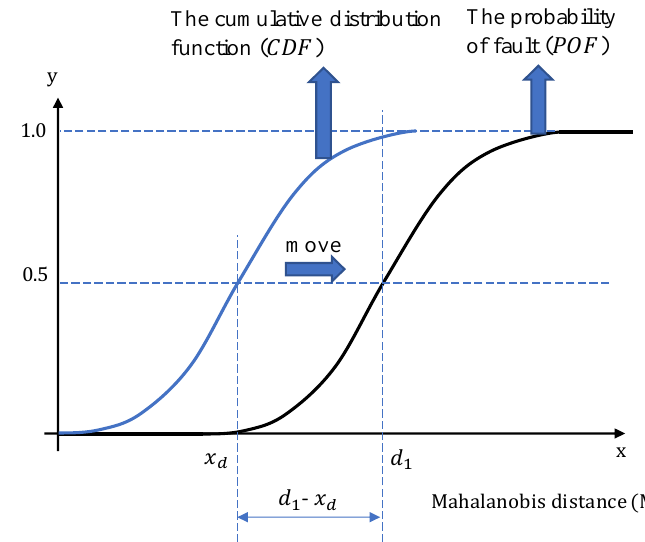
Figure 4. The proposed probability of fault ( 𝑃𝑂𝐹 ) model.